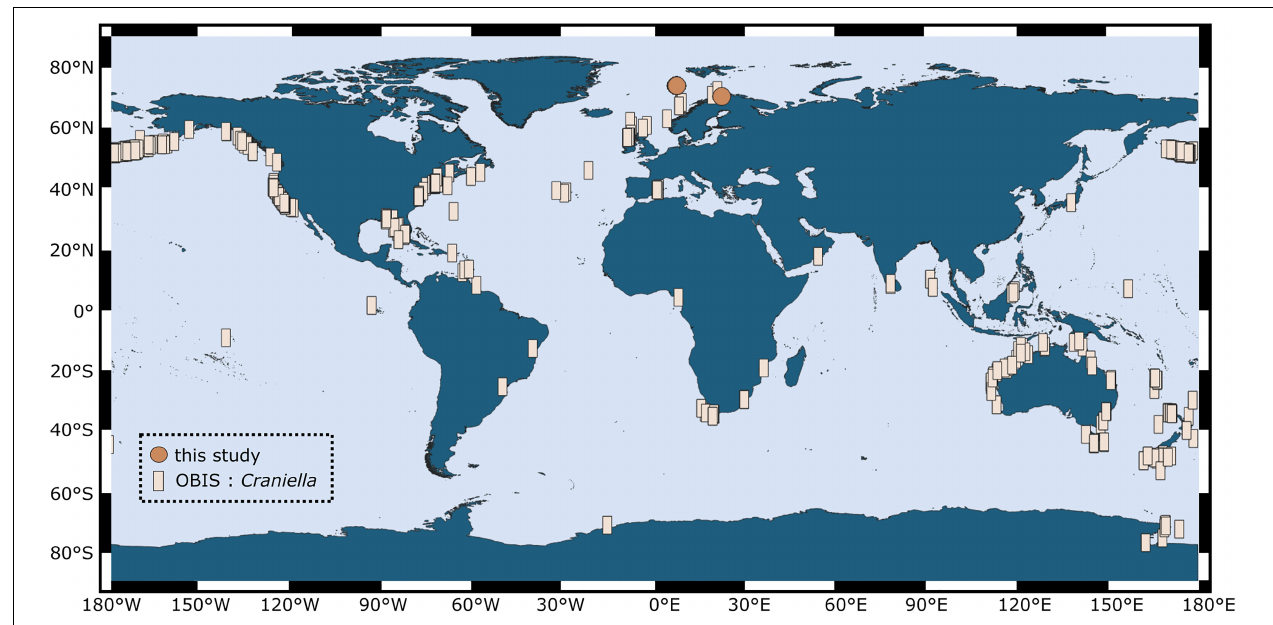
FIGURE 1 | Global distribution of the genus Craniella , as compiled from records in the Ocean Biogeographic Information System (OBIS; squares) in March 2020. Sampling locations of individuals from our study are indicated by points.